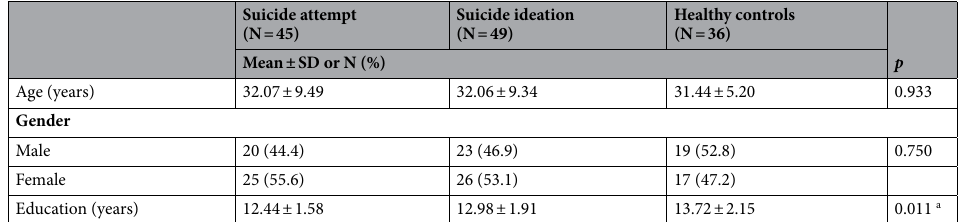
Table 1. Comparison of baseline demographic data among MDD patients with suicide attempts and suicide ideation, and healthy controls. a With suicide attempt vs. with suicide ideation, p = 0.169; with suicide attempt vs. healthy control, p = 0.003; with suicide ideation vs. healthy control, p = 0.073.